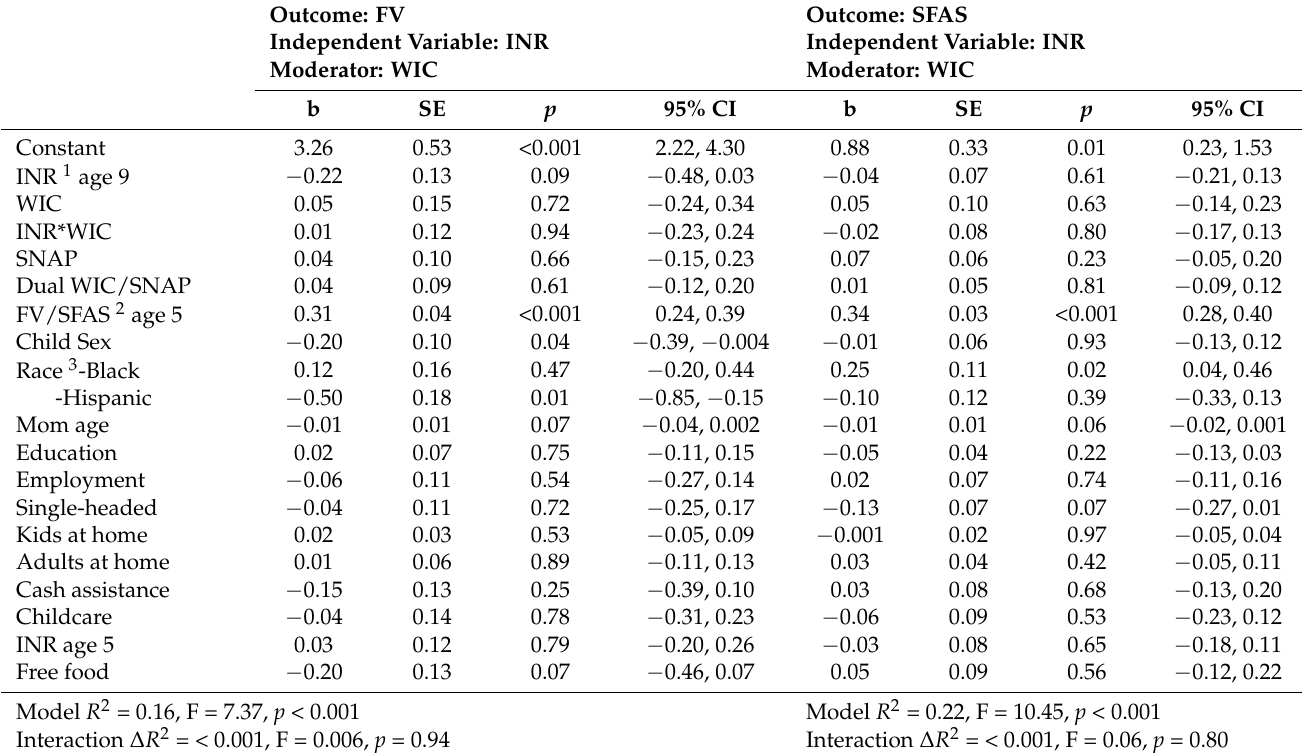
Table 2. Accumulation of WIC on Change in FV and SFAS Intake from Ages 5 to 9 Years ( n = 733).